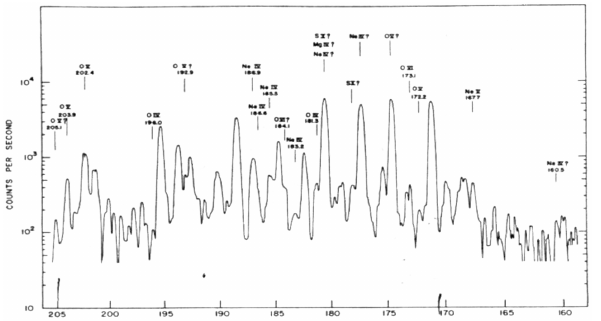
Figure 10. Photoelectric recording of solar flux from 205 to 160Å, 20.5–16.0nm (Hinteregger et al., 1964; ©AAS, reproduced with Figure 10: Photoelectric recording of solar flux from 205-160 Å / 20.5-16.0 nm permission). (Hinteregger et al., 1964, © AAS, reproduced with permission).